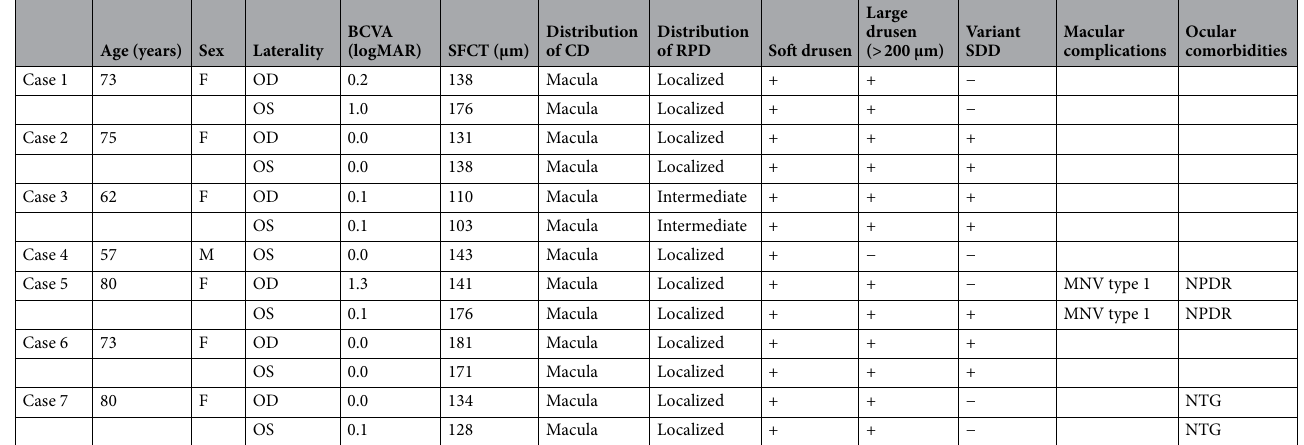
Table 1. Characteristics of eyes presenting with cuticular drusen and reticular pseudodrusen. BCVA, best- corrected visual acuity; CD, cuticular drusen; logMAR, logarithm of the minimum angle of resolution; MNV, macular neovascularization; NPDR, non-proliferative diabetic retinopathy; NTG, normal tension glaucoma; RPD, reticular pseudodrusen; SDD, subretinal drusenoid deposit; SFCT, subfoveal choroidal thickness; M, male; F, female; OD, right eye; OS, left